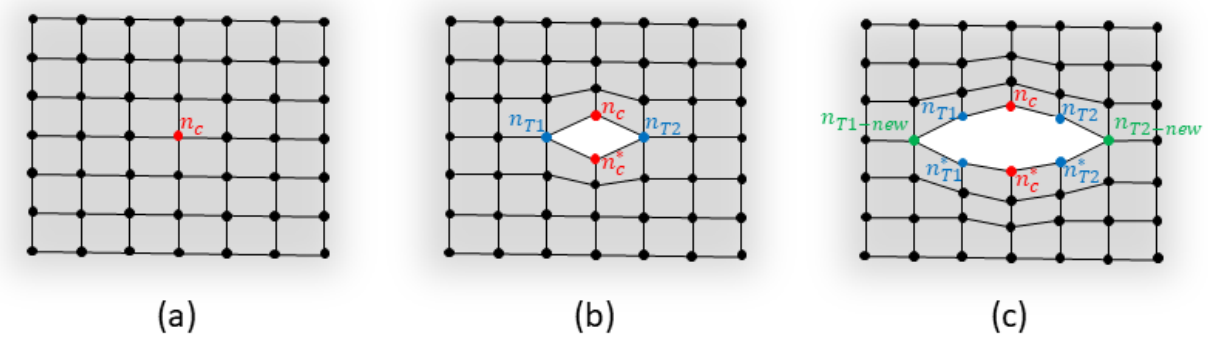
Figure 3. Crack propagation routine: ( a ) identification of the crack center (red node); ( b ) crack introduction; ( c ) crack propagation. Algorithm 1: Crack center identification and introduction on an undamaged structure